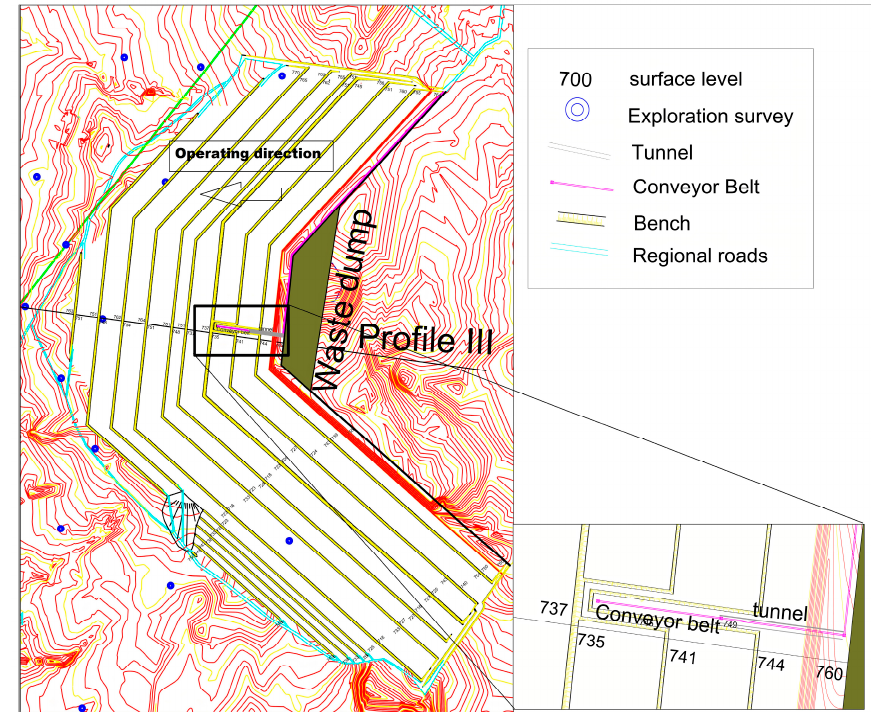
Figure 4. The first phase of exploitation with environmental recovery showing the conveyor belt location.